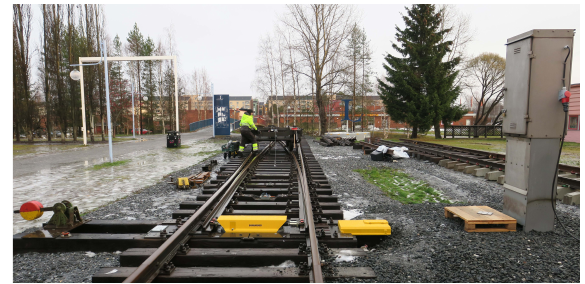
Figure 1. View of the test